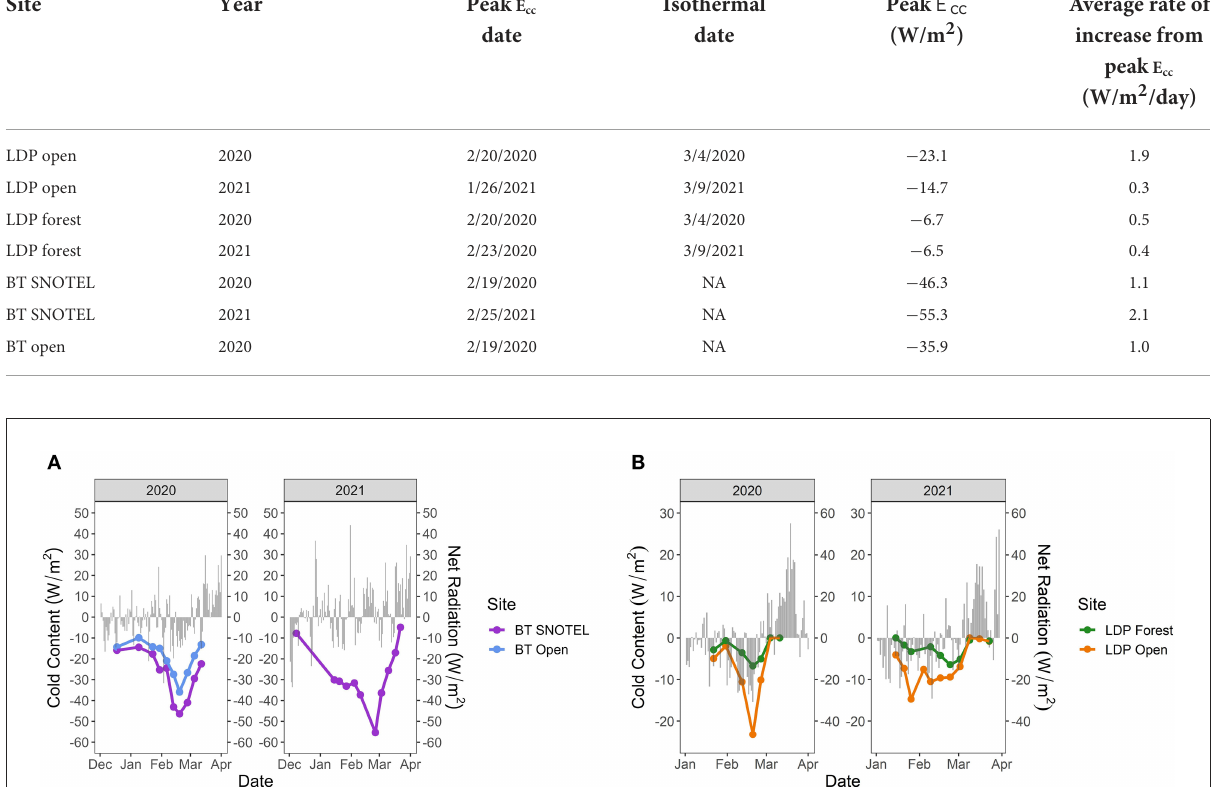
TABLE 4 Cold content ( E cc ) timing and rate of increase towards isothermal at the LDP and BT snow pit sites for 2020 and 2021. Site